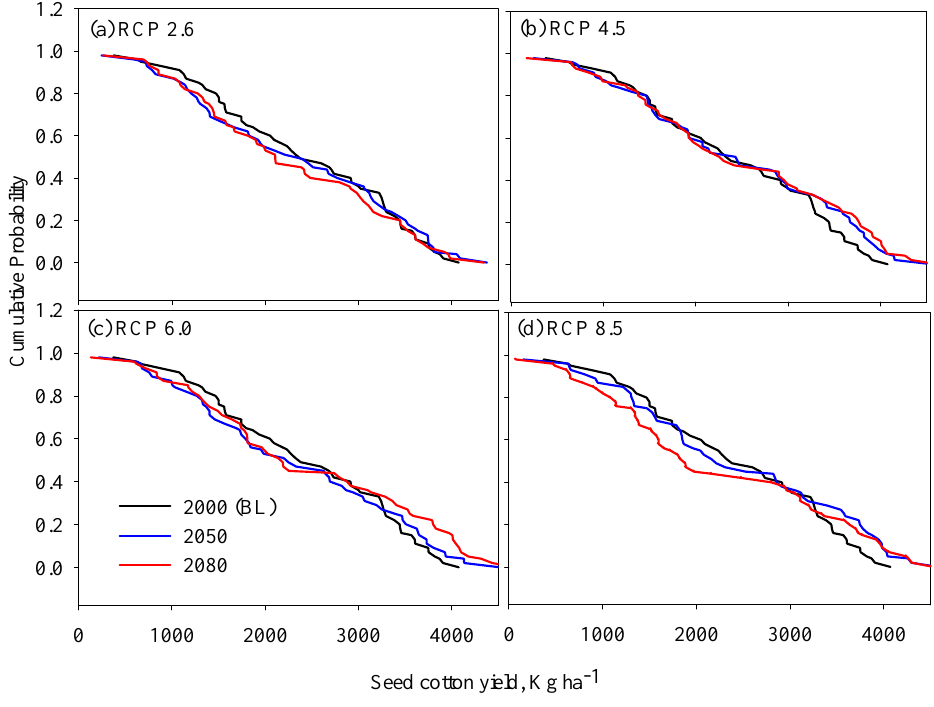
Figure 9. Simulated impacts of climate change (changes in temperature, rainfall, and CO 2 ) on rainfed seed cotton yield in 2050 and 2080 for RCP 2.6 ( a ), 4.5 ( b ), 6.0 ( c ), and 8.5 ( d ) emission